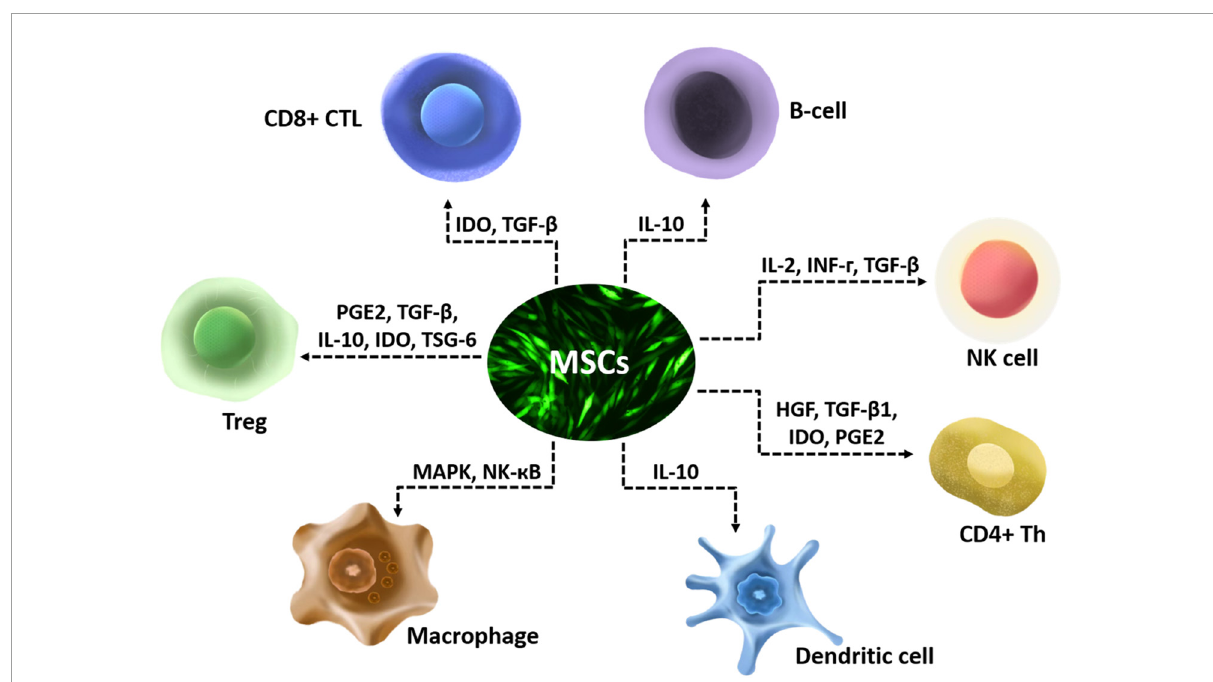
FIGURE1 Schematic diagram of immunoregulatory properties of mesenchymal stem cells